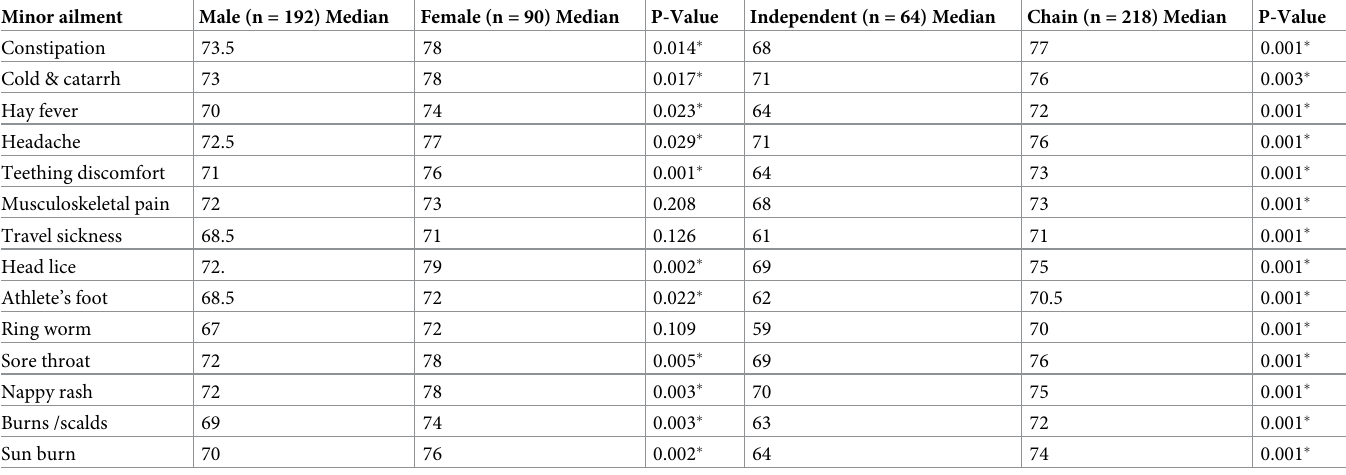
Table 4. Comparison of community pharmacists’ self-perceived competency to manage minor ailments across gender and community pharmacy types (N = 282].